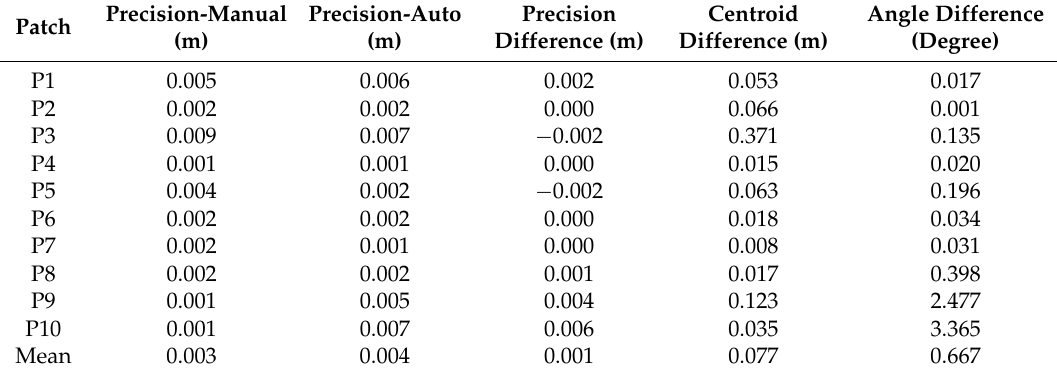
Table 9. Plane fitting precision, plane fitting precision difference, centroid difference, and angle difference values for building #4 (Adaptive cylindrical